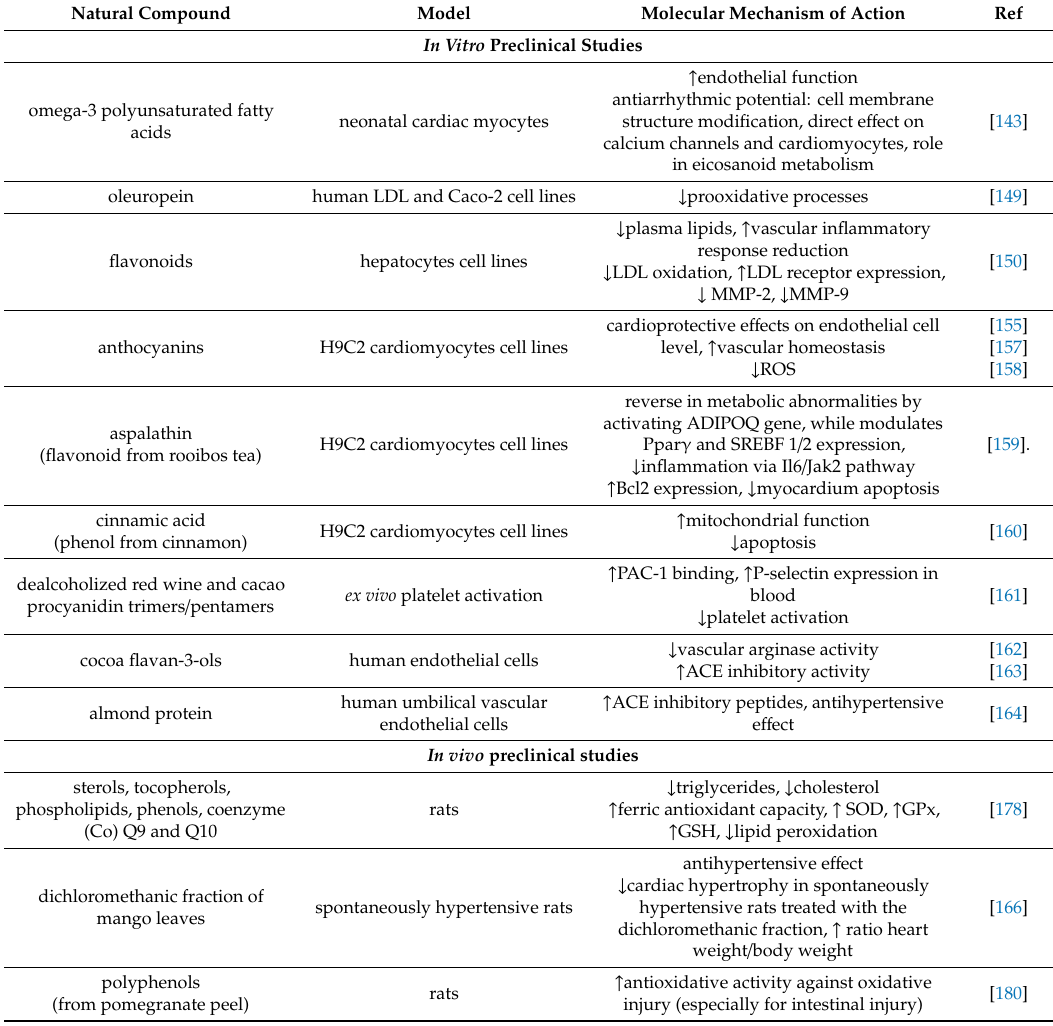
Table 2. “ In vitro ” and “ in vivo ” preclinical studies - cardioprotective e ff ects and molecular mechanisms of plant-food